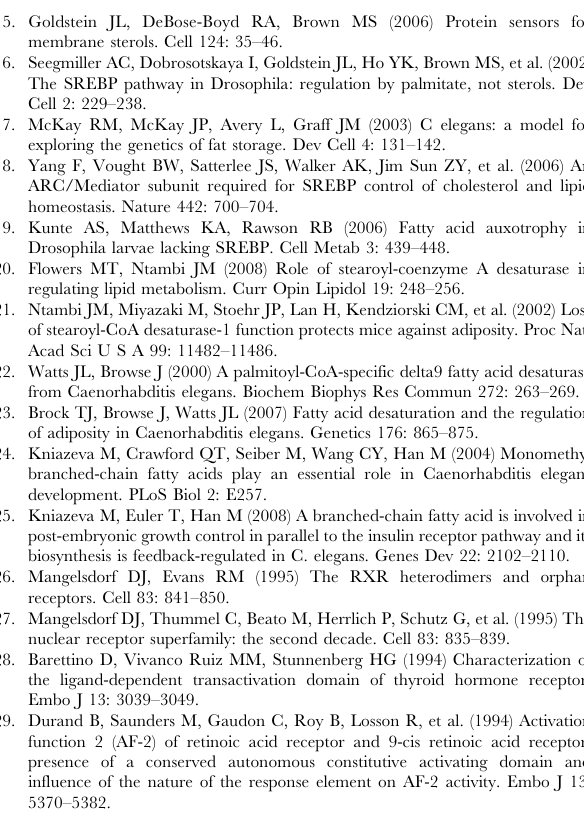
Table S1 Genes analyzed in quantitative RT-PCR